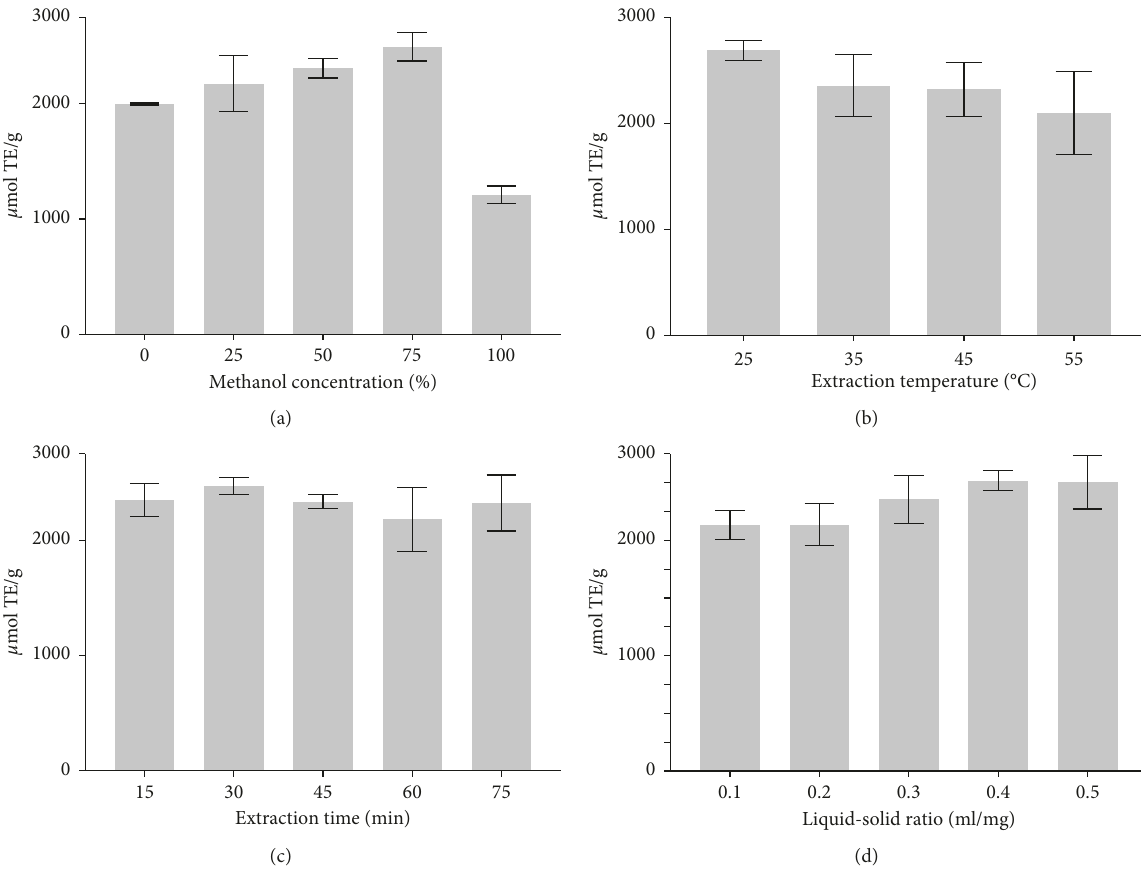
Figure 1: Influence of the methanol concentration (a), extraction temperature (b), extraction time (c), and liquid-solid ratio (d) on the extraction yield of antioxidant